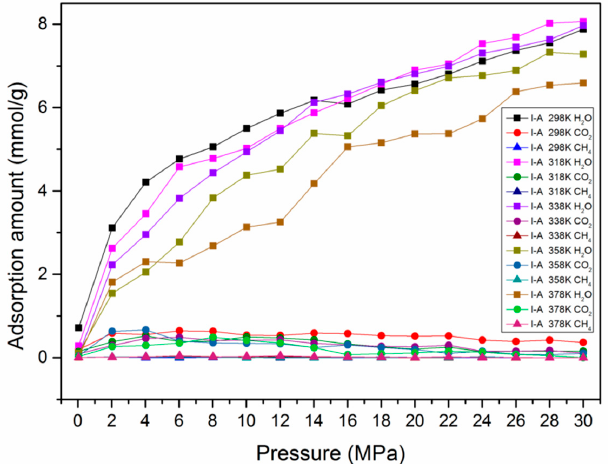
Figure 7. The adsorption amounts of H 2 O, CH 4 , and CO 2 with pressure in type I-A kerogen at different temperatures.